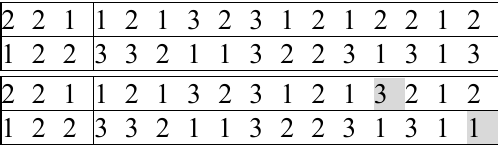
Fig. 3. Modification